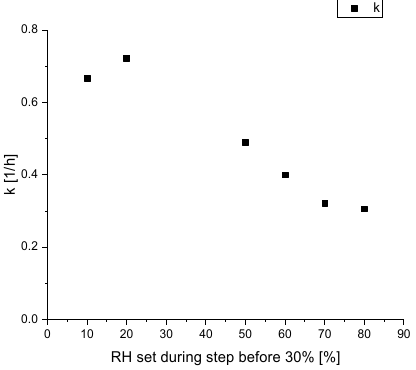
Figure 6. Calculated reaction rate constant k during the desorption process of water on silica gel at a relative humidity of 30%, depended on the former relative humidity.